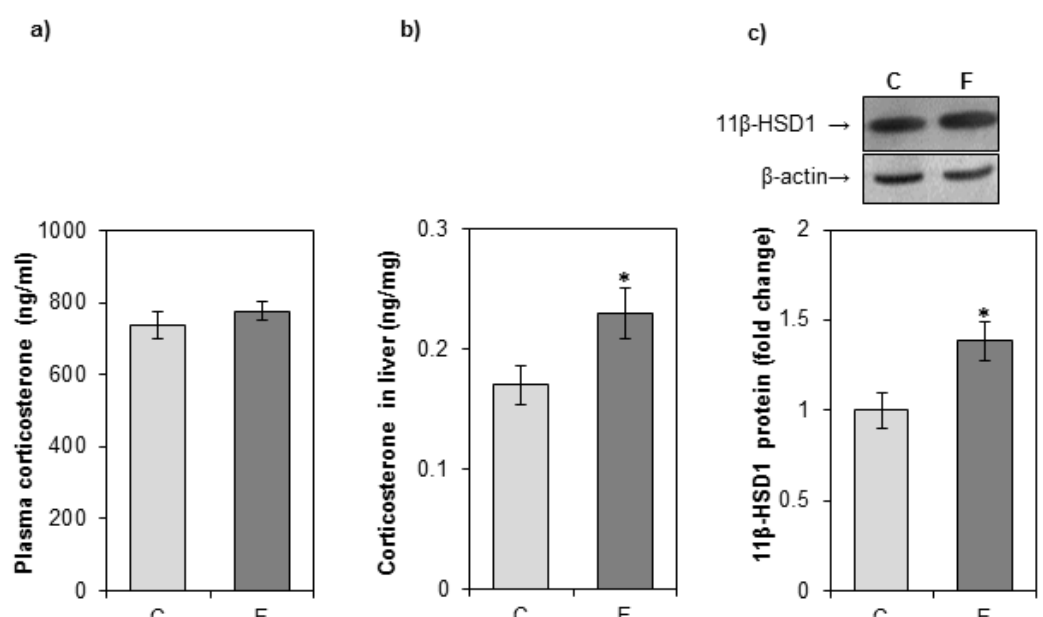
Figure 1. The e ff ects of a fructose-rich diet on plasma and liver corticosterone concentrations, and the level of hepatic 11 β HSD1. Groups: control (C), fructose-fed (F). Corticosterone concentrations in plasma ( a ) and liver ( b ) were measured by EIA kit. 11 β HSD1 protein level in hepatic microsomal fraction ( c ) was measured by Western blot. Relative integrated optical density of the immunoreactive bands was assessed by ImageQuant software, normalized to β -actin, and expressed as fold of the control. The values represent the means ± SEM ( n = 9). Statistical significance of di ff erences between experimental groups: * p < 0.05.